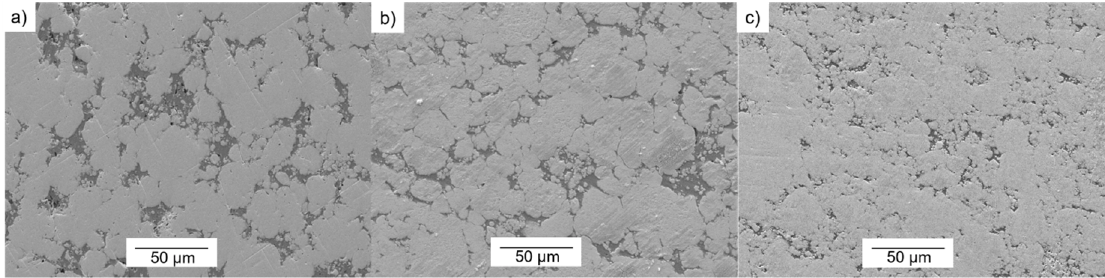
Figure 3. Secondary Electron-SEM images of 85-W/15-Cu alloys prepared from three powder mixings: ( a ) 10-W f :90-W c ; ( b ) 20-W f :80-W c ; ( c ) 30-W f :70-W c . ( a ) 10-W f :90-W c ; ( b ) 20-W f :80-W c ; ( c ) 30-W f :70-W c